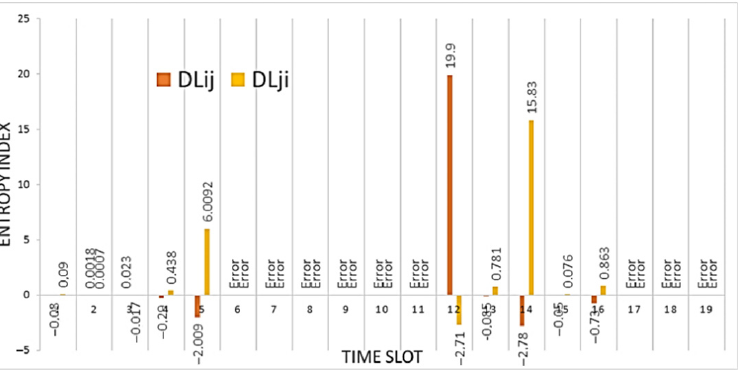
Figure 14. The result of calculating the entropy for: ( a ) received packets; and ( b ) packets sent by node i relative to node j (marked in blue) and by node j relative to node i (marked in orange) under conditions of a deauthentication attack.